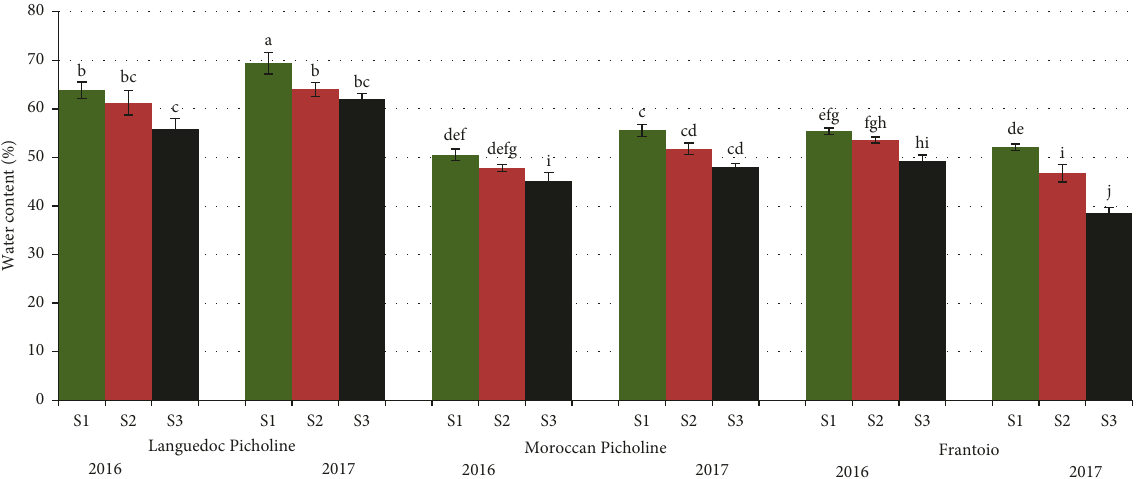
Figure 6: Water contents (% FW) of different olive cultivars grown in Marrakech (Morocco) at different stages of maturity (S1: green; S2: purple; S3: black). Values are means ± standard deviation (SD) of three replications. Data followed by different letters are significantly different from each other ( P < 0 . 05) according to LSD